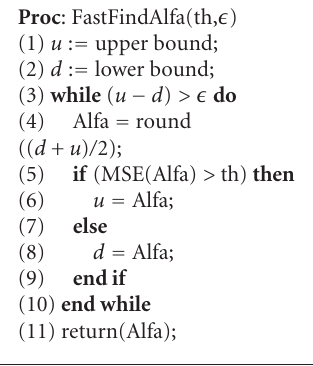
Algorithm 2: Fast algorithm for finding Alfa ∗ .